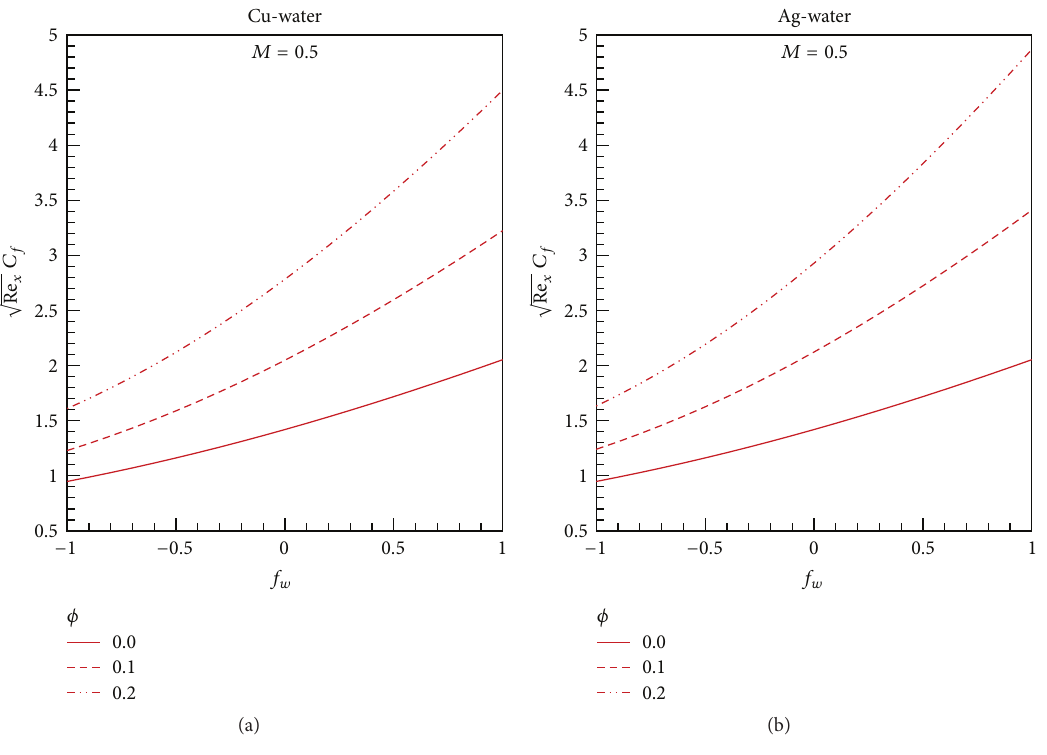
Figure 6: Variation of skin friction with 𝑓 𝑤 and 𝜙